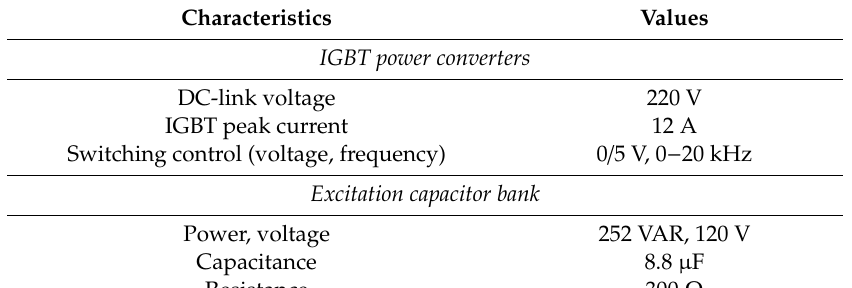
Table 2. Characteristics of the converters and the excitation capacitor bank.